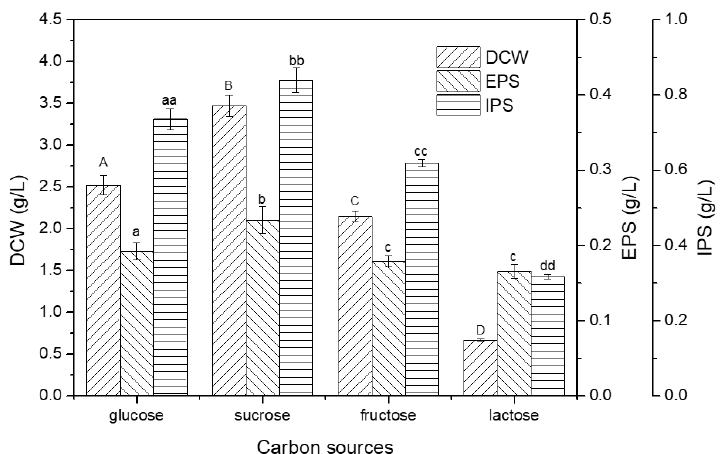
Figure 1. Effect of different carbon sources on mycelial growth (DCW: dry cell weight) and polysaccharides (EPS: exopolysaccharide; IPS: intracellular polysaccharide) production. Different letters above bars in the upper case indicate significant difference ( p < 0.05) in DCW, different letters above bars in lower case indicate significant difference ( p < 0.05) in EPS, and different letters above bars in double lower case indicate significant difference ( p < 0.05) in IPS.